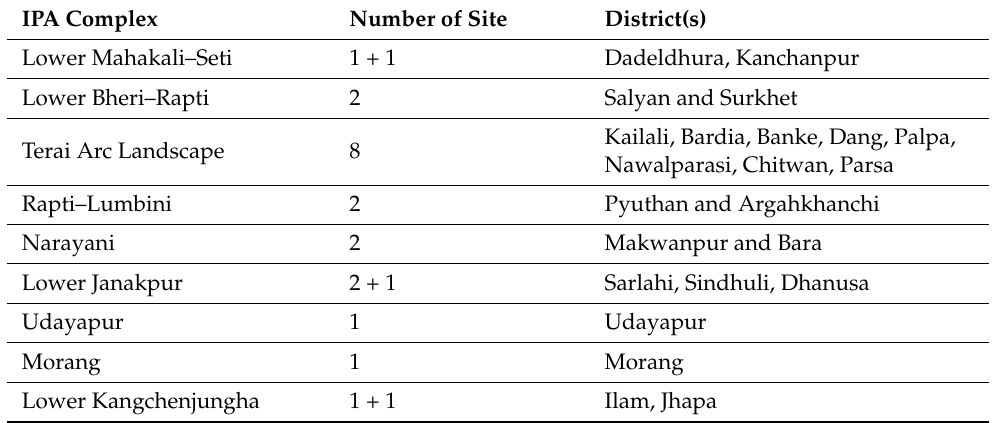
Table 3. Important Plant Areas in